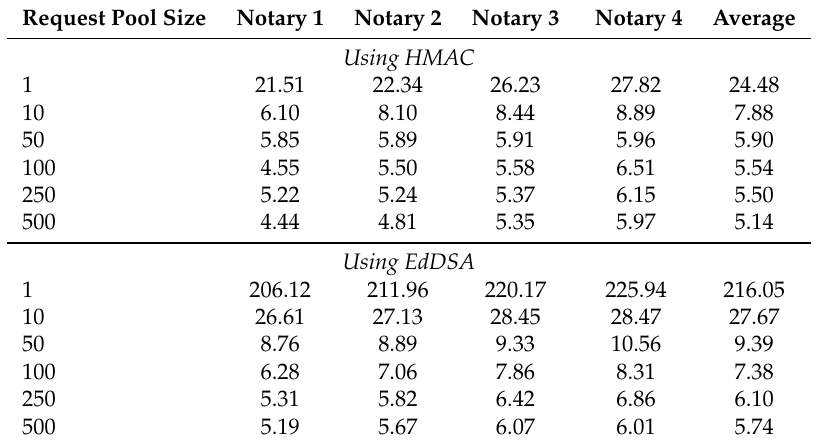
Table 2. The benchmark result of the Core Engine latency (in milliseconds) with a variation of Request Pool